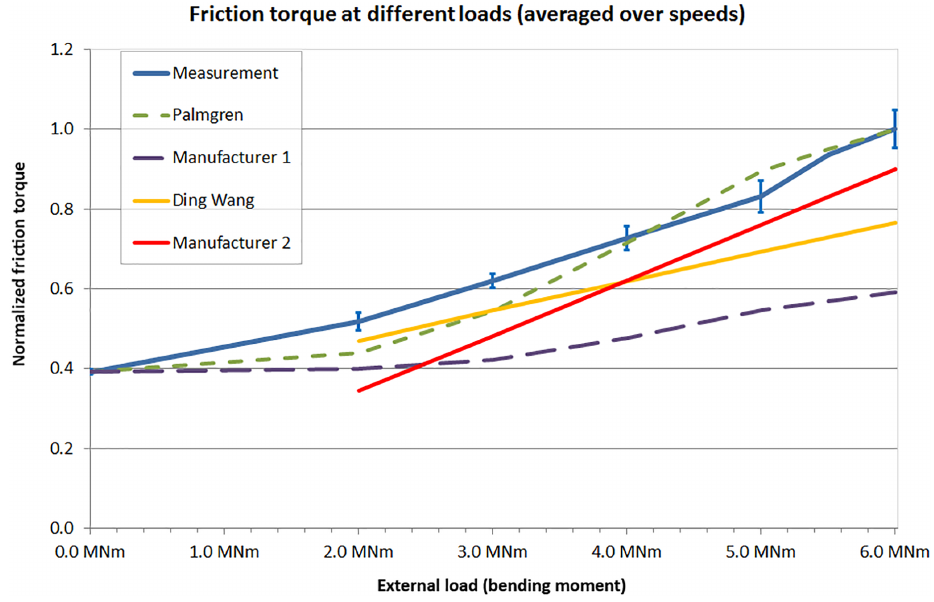
Figure 7. Measured and calculated friction torque at different loads.